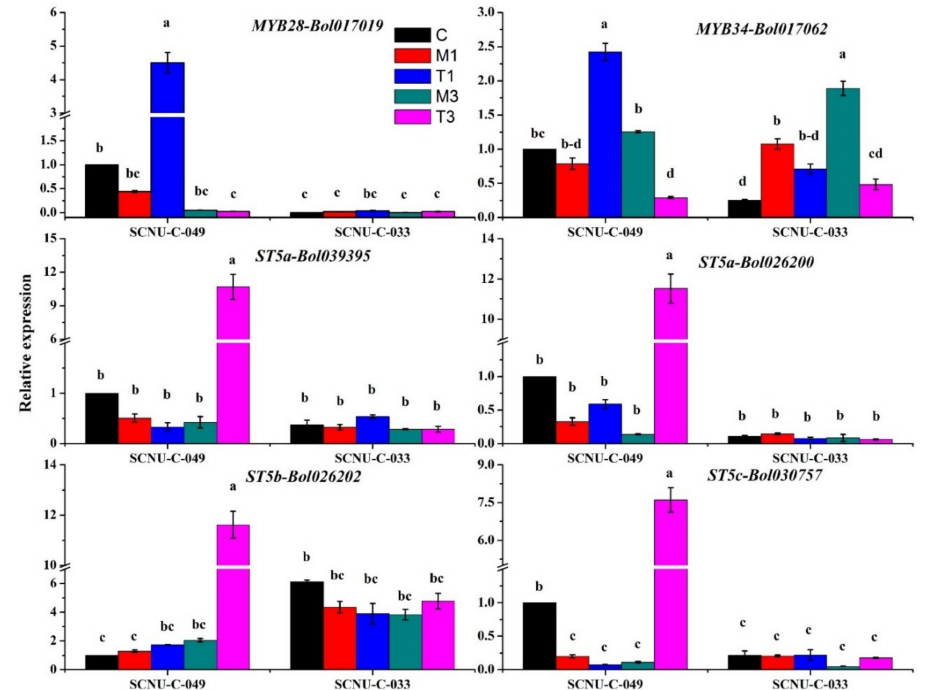
Figure 3. Upregulation of MYB28-Bol017019, MYB34-Bol017062, ST5a-Bol026200, ST5a-Bol039395, ST5b-Bol026202 and ST5c-Bol030757 genes in white-mold-inoculated R (SCNU-C-049) line at 1 and 3 DPI compared to mock-treated plants. No similar upregulation was seen in a susceptible (S; SCNU-C-033) line. C, control; M1, mock day 1; T1, treated day 1; M3, mock day 3; T3, treated day 3. The means of three biological replicates are presented. Vertical bars indicate standard deviation. Different letters indicate statistically significant differences between R and S lines and treatment interactions. R, resistant; S,